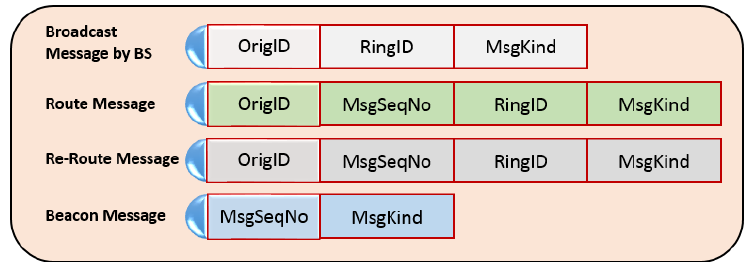
Figure 5. Message formats used in RARZ.